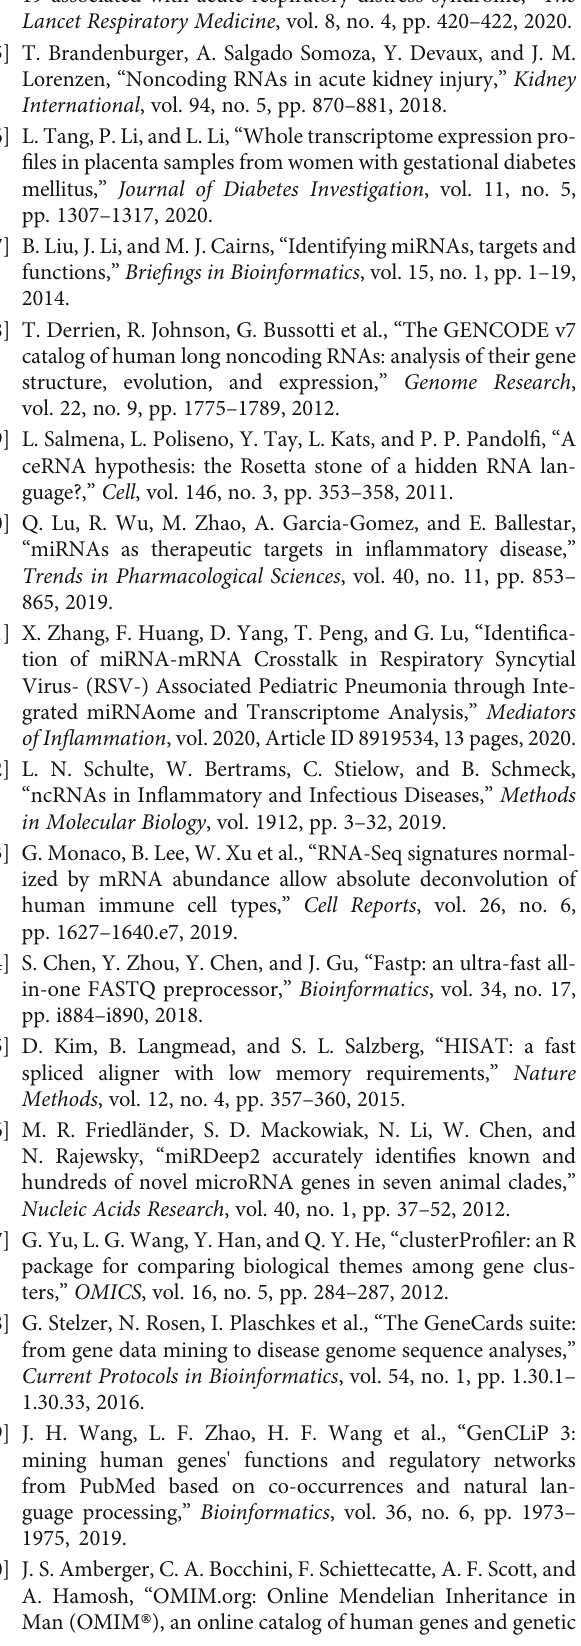
Table S1: the di ff erentially expressed mRNAs of peripheral blood samples in COVID-19 patients. Table S2: the di ff eren- tially expressed miRNA of peripheral blood samples in COVID-19 patients. Table S3: the di ff erentially expressed lncRNAs of peripheral blood samples in COVID-19